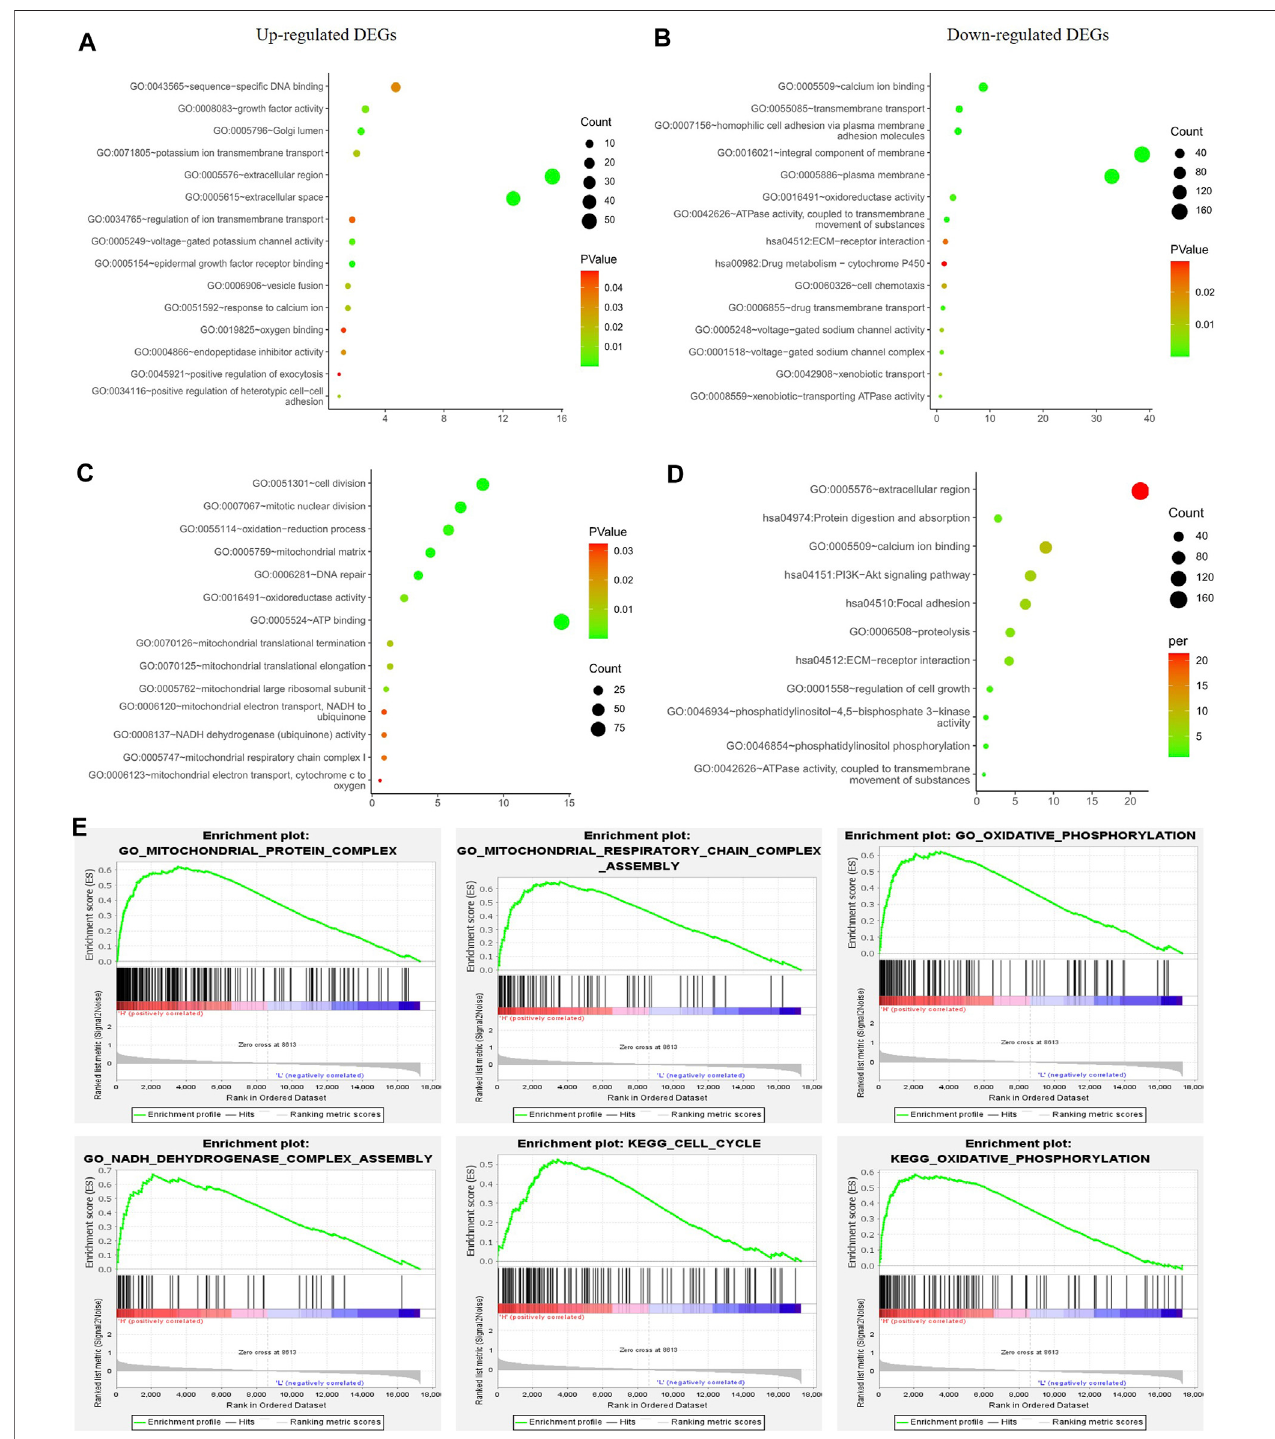
FIGURE4| Functionenrichmentanalysesforthedifferentiallyexpressedgenesbetweenlow-andhigh-PGRMC1expressiongroupinTNBCsamples. (A) Function enrichment analyses of up-regulated DEGs in TNBC samples of TCGA-BRCA. (B) Function enrichment analyses of down-regulated DEGs in TNBC samples of TCGA- BRCA. (C) Functionenrichmentanalysesofup-regulatedDEGsinTNBCsamplesofGSE164458dataset. (D) Functionenrichmentanalysesofdown-regulatedDEGsin TNBC samples of GSE164458 dataset. (E) GSEA results for high PGRMC1 expression groups in TNBC samples of METABRIC dataset.